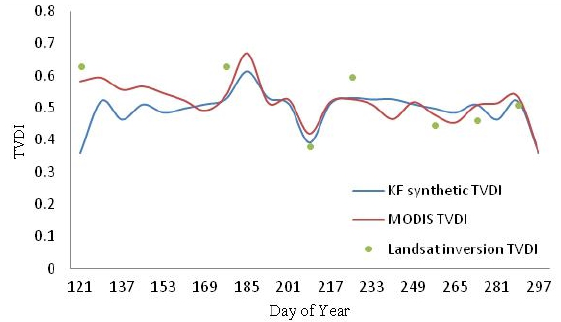
Figure 3. Comparison of MODIS TVDI, the simulated TVDI by Kalman filter algorithm and the Landsat retrieval